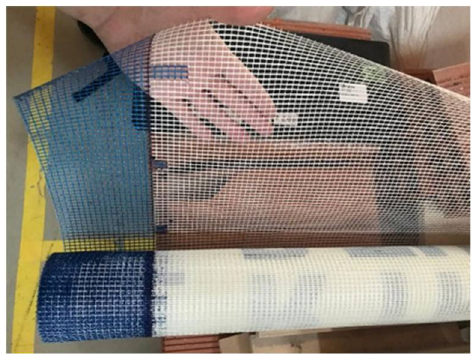
Figure 2. Fibreglass mesh.